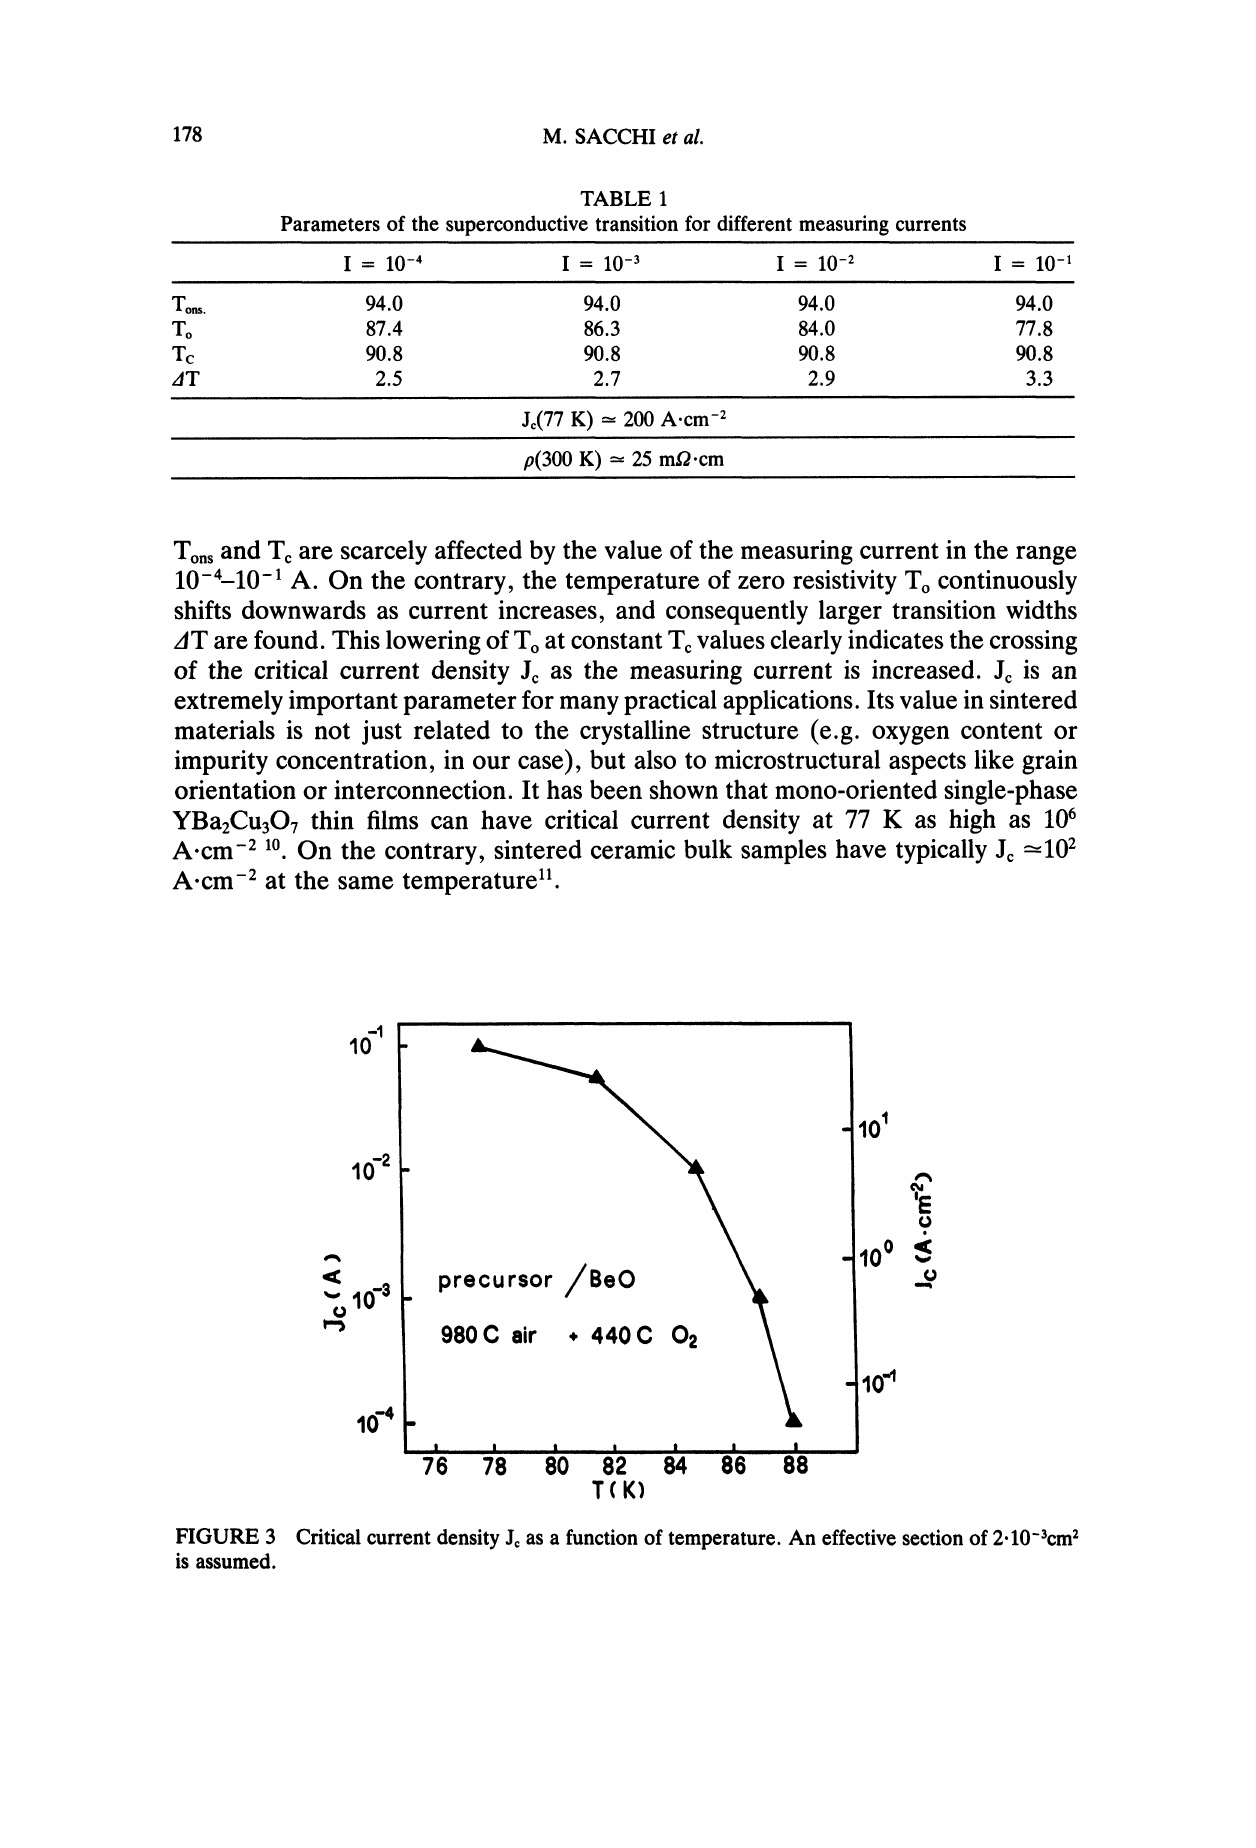
FIGURE 3 Critical current density Jc as a function of temperature. An effective section of 2.10-acm is